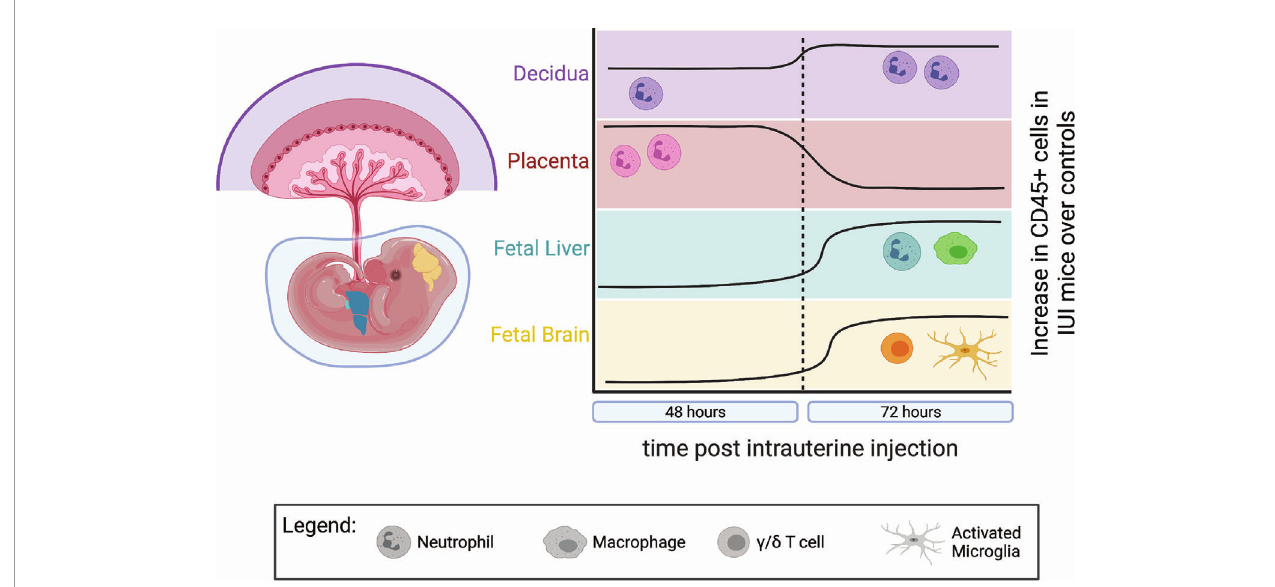
FIGURE 9 | Temporal dynamics of immune in fi ltrates differed in each anatomic compartment. IUI-exposed mice had more CD45+ cells compared to controls in each examined tissue, but at different times post-uterine injection and with different immune subtypes. This fi gure demonstrates: the lasting neutrophil in fi ltrate in the decidua (purple) at 48 and 72 hours post-uterine injection; the neutrophil in fi ltrate to the placenta (pink) at 48 hours that normalizes to control levels by 72 hours; the increase in macrophages and neutrophils to the fetal liver (green) at 72 hours; and the increase in g / d T cells and activated microglia in the fetal brain (yellow) at 72 hours post-uterine injection. (Figure made using BioRender